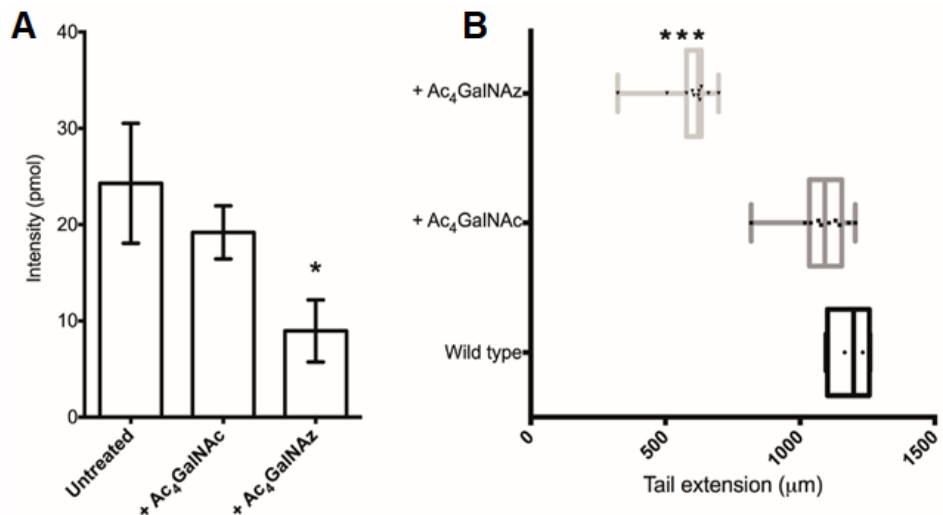
Figure 6. Ac 4 GalNAz treatment of Xenopus embryos. ( A ) Total HS (pmol) per embryo. ( B ) Embryo stature measurements of the tail extension ( µ m). + Ac 4 GalNAz, 500 pmol injection and 500 µ M soaking; + Ac 4 GalNAc, 500 pmol injection and 500 µ M soaking. * p ≤ 0.05, *** p ≤ 0.001 + Ac 4 GalNAz vs. Wildtype. Oneway ANOVA with Turkey post-hoc comparison.